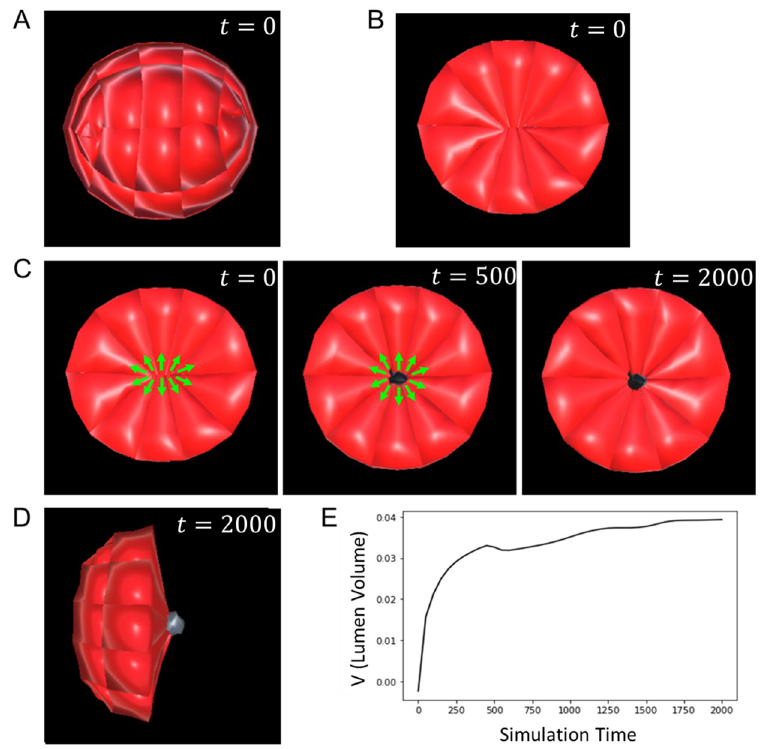
Fig 3. Lumenogenesis in the epiblast. A . A 3D model of a rosette-shaped epiblast. B . A 2D slice of the epiblast in A showing apically constricted cells of the building block of the epiblast rosette. C . Creation of the lumen cavity by repulsion at the apical surface of the epiblast. Green arrows represent the direction of repulsive forces. The snapshots (from left to right) were taken respectively at t = 0, 500 and 2000. D . Lateral view of the sliced epiblast showing the lumen volume. The lumen has been greyed to allow a better view over the black background. E . Evolution over time of the volume of the lumen. Values of the equation parameters: J EPI = 2.5, λ = 2, ρ = 1, R lum =